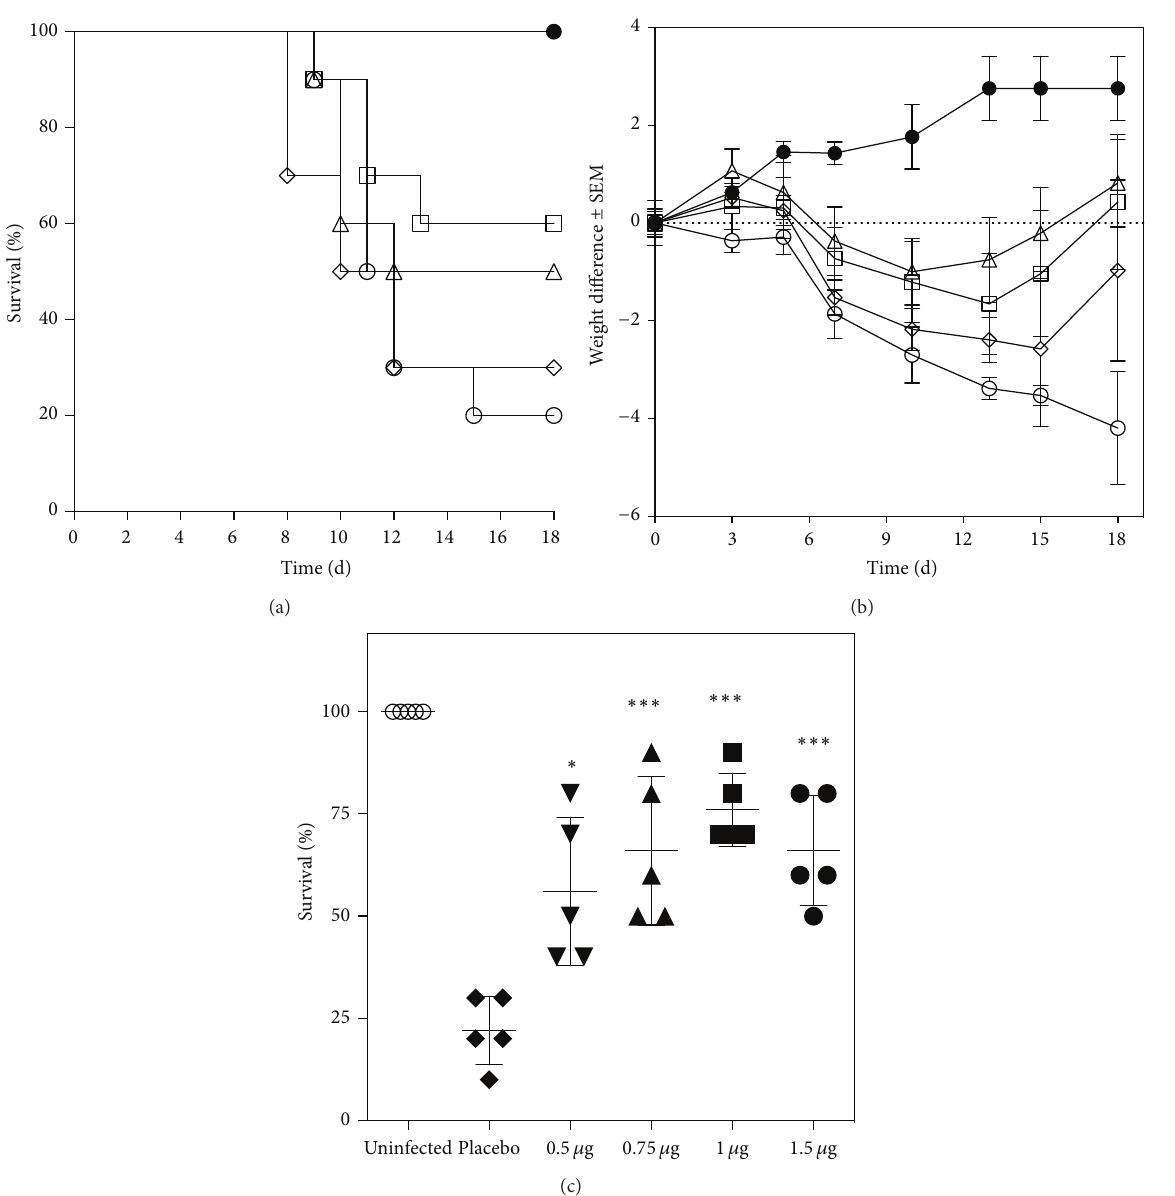
Figure 2: Validation of the murine herpes model for the evaluation of Transferon activity. (a) Survival curves for HSV-1 infected mice. Treatmentswith1 𝜇 g(opentriangles)or0.125 𝜇 g(opensquares)ofTransferonimprovedsurvivaloverplacebo(opencircles;Log-rankMantel- Cox test; 𝑃 < 0.01 ). In contrast, 12.5 ng of Transferon (open diamonds) had no significant effect. A group of mice was left uninfected (closed circles) as control. (b) Weight changes in HSV-1 infected mice. Transferon partially protects mice from the weight loss induced by HSV- 1 (symbols are as in (a)). (c) Survival induced by five different Transferon batches was evaluated during a validation protocol. All batches improved survival versus placebo (Bonferroni t test; ∗ 𝑃 < 0.05 , ∗∗ 𝑃 < 0.01 ; ∗∗∗ 𝑃 < 0.001